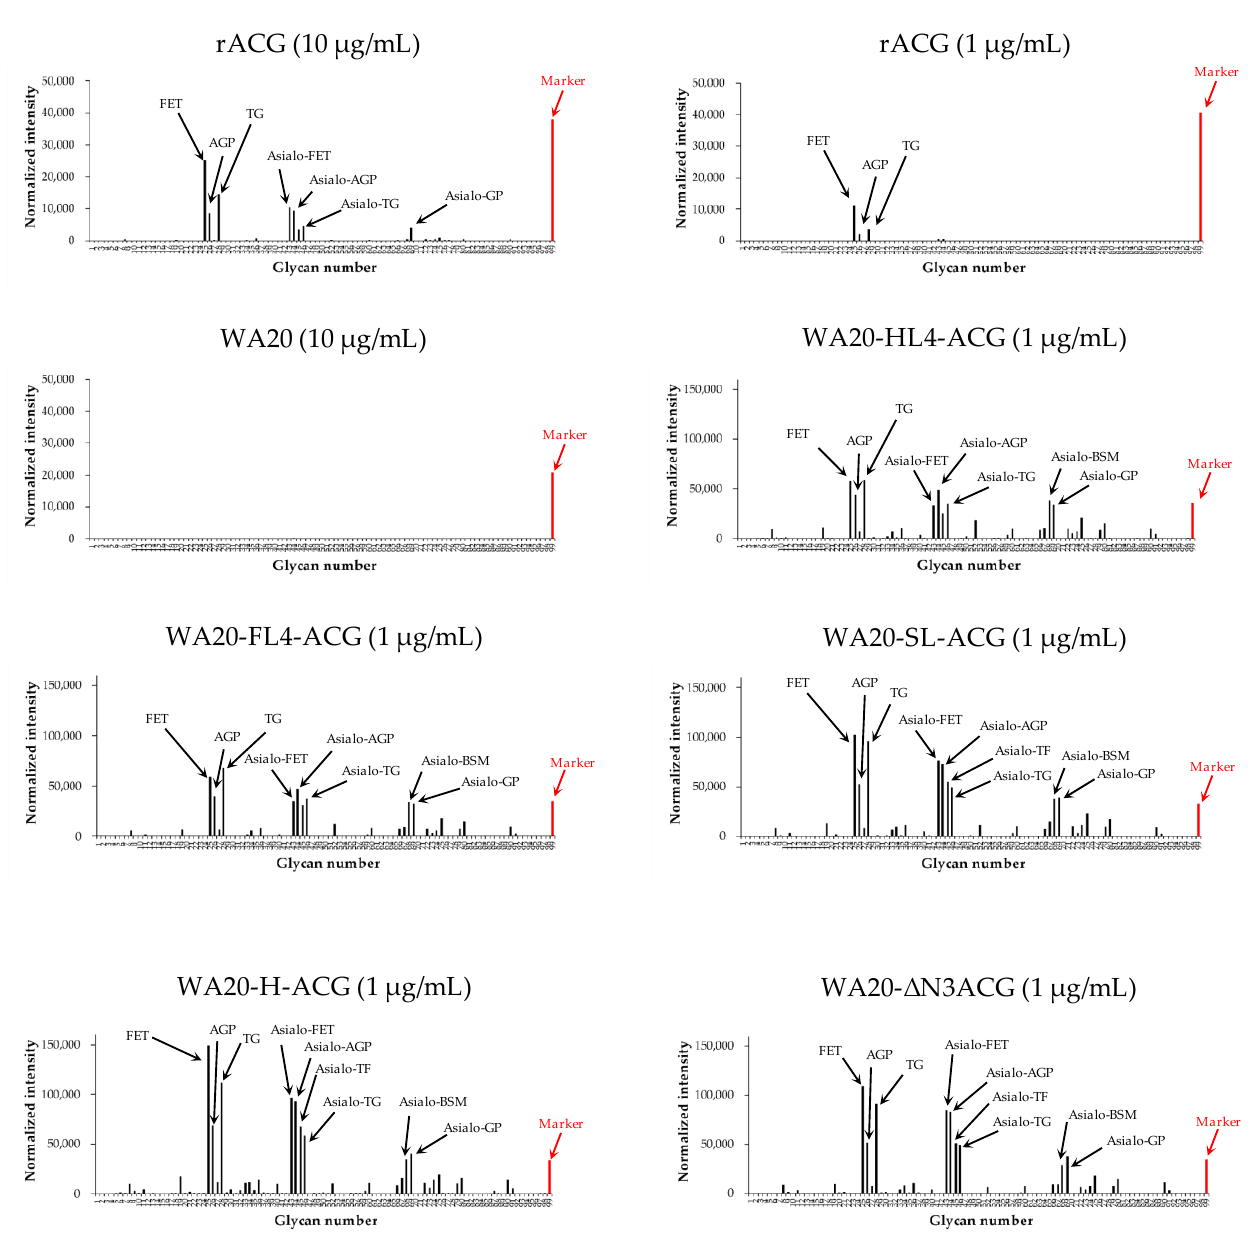
Figure 5. Glycoconjugate microarray analysis. Specificity profiles of rACG, WA20, and the five lectin nano-blocks. The Cy3-labeled proteins (1 µg/mL or 10 µg/mL) were applied to the array, and bind- ing was detected by the scanner multiple times by varying the exposure time (0.1 – 3 s). The fluores- cent intensity was normalized to the intensity per second. Abbreviations: FET, fetuin ; AGP, α1 -acid glycoprotein; TG, porcine thyroglobulin; TF, transferrin; BSM, bovine submaxillary mucin, and GP; human glycophorin.